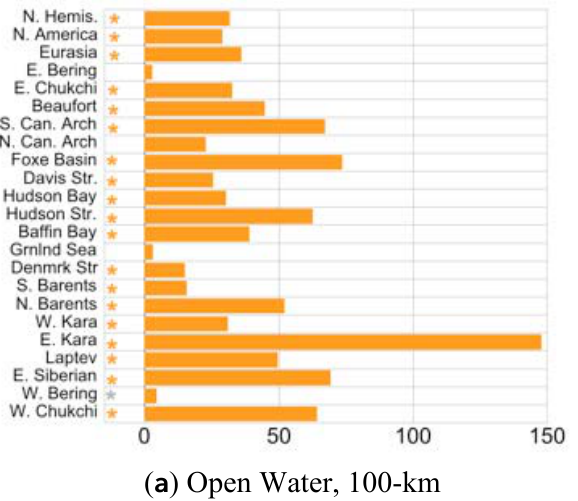
Figure 4. Regional trends shown as a percent change from 1982 to 2011 (calculated using the least squares fit method) for ( a ) summer open water (percent), ( b ) land summer warmth index (SWI) (°C month), ( c ) MaxNDVI (unitless), and ( d ) Time-Integrated NDVI (unitless). The ocean domain (sea ice) is the 100-km coastal zone and the land domain (SWI, MaxNDVI, and TI-NDVI) is the full tundra as defined by the CAVM [19] and regions indicated in Figure 1. Colored (Grey) stars indicate trend significance at the 95% (90%) level or